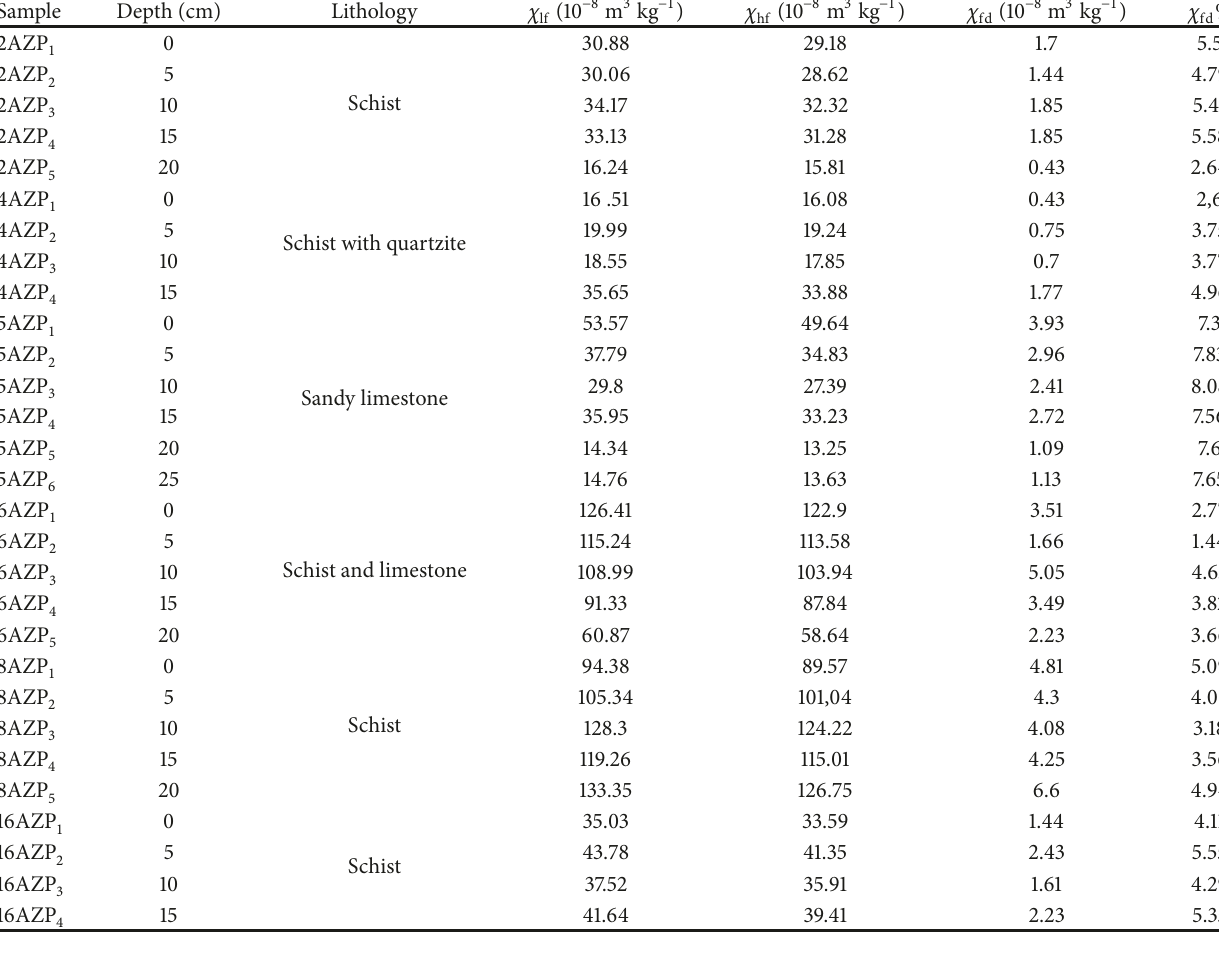
Table 4: Magnetic parameters measured on the different samples of Ait Azzouz pastures land.